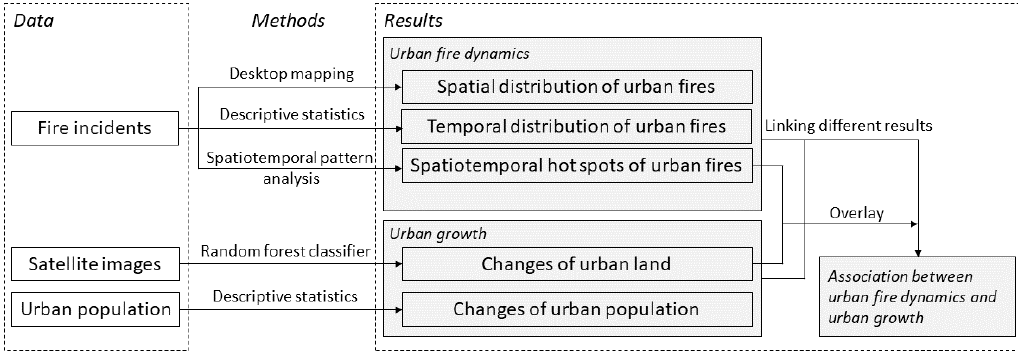
Figure 1. Research framework.